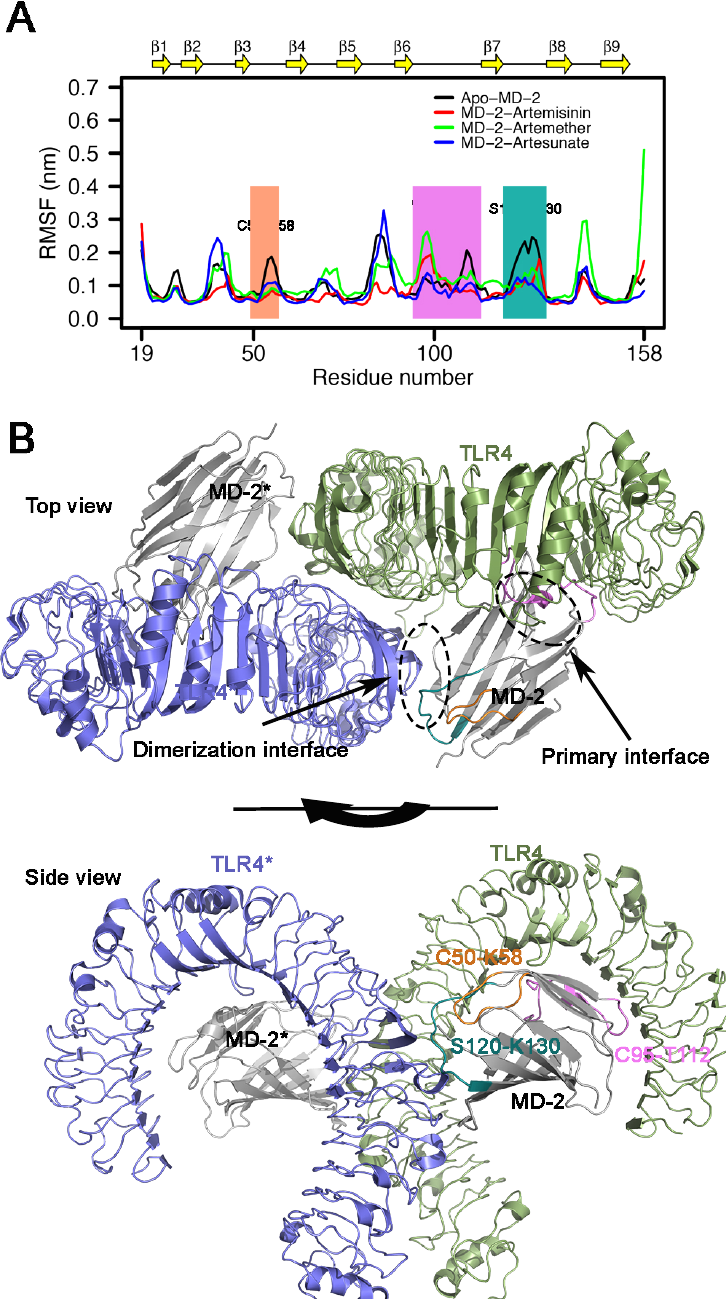
Figure 5. ( A ) Root mean square fluctuation in the last 50ns of all systems with different colors. Significant fluctuations of loop regions are labeled. ( B ) Dimeric structure of the mTLR4/MD-2 complex. TLR4 and MD-2 are shown in green and gray, respectively, and their dimerization partners TLR4* and MD-2* are shown in blue and gray, respectively. Loop region C50–K58 is in orange, C95–T112 is in pink and S120–K130 is in